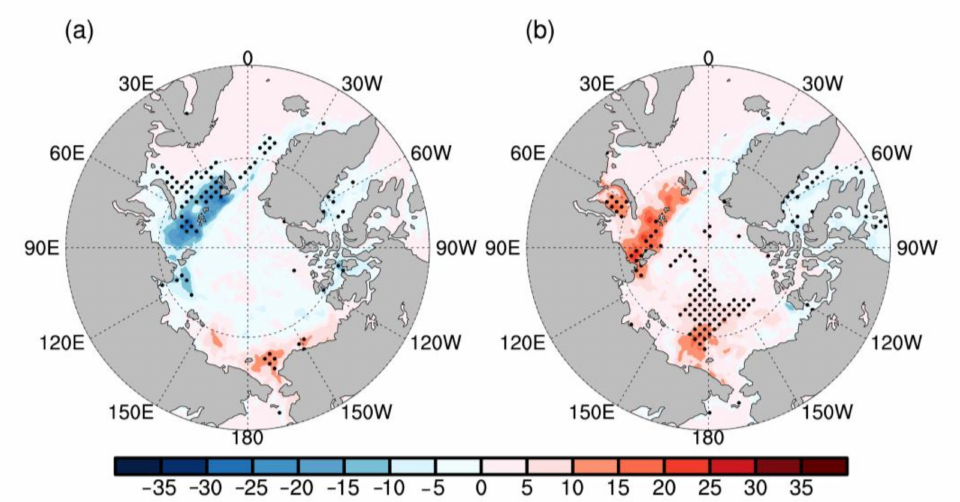
Figure 10. Composite maps of the Arctic autumn SIC anomaly (shaded, unit: %) in years with ( a ) TN10p_IAP and ( b ) TN10p_IAN. The dotted region indicates significance at the 95% level from the t